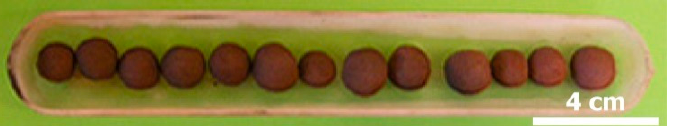
Figure 9. Optical image of pellets (35% hematite + 35% W-PVC + 30% clay) treated at 300 °C for 30 min.